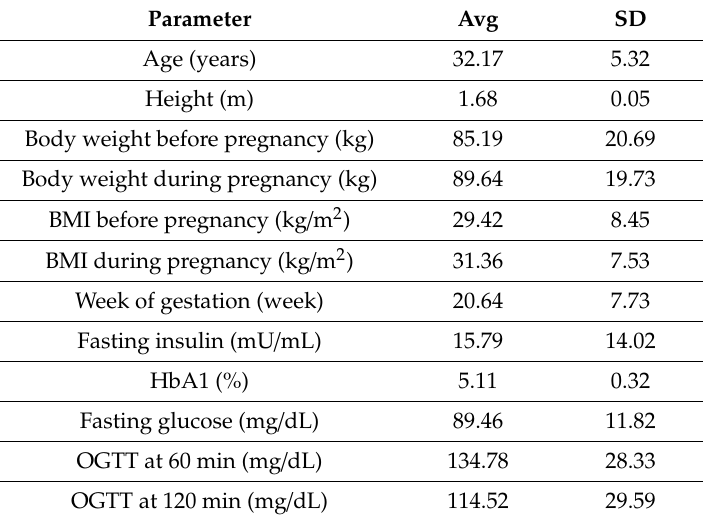
Table 6. Characteristics of the study group of women ( n = 90).